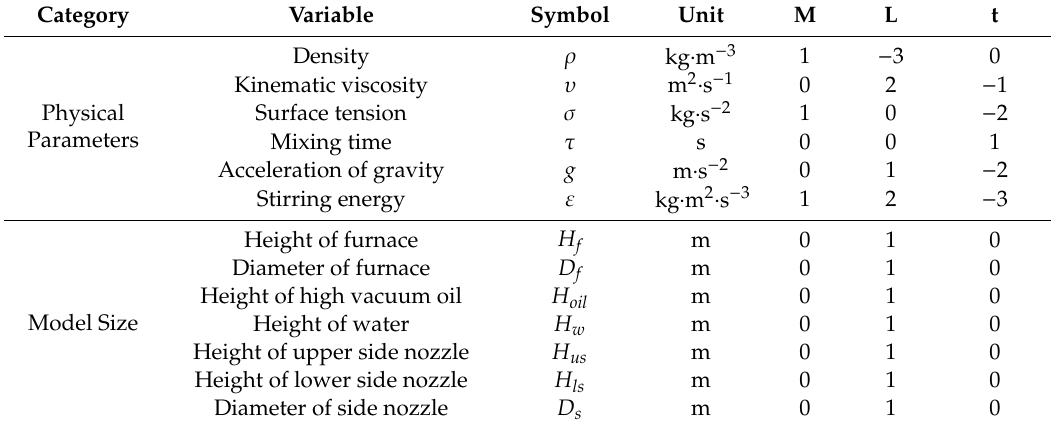
Table 2. Selected parameters for the dimensional analysis of the mixing